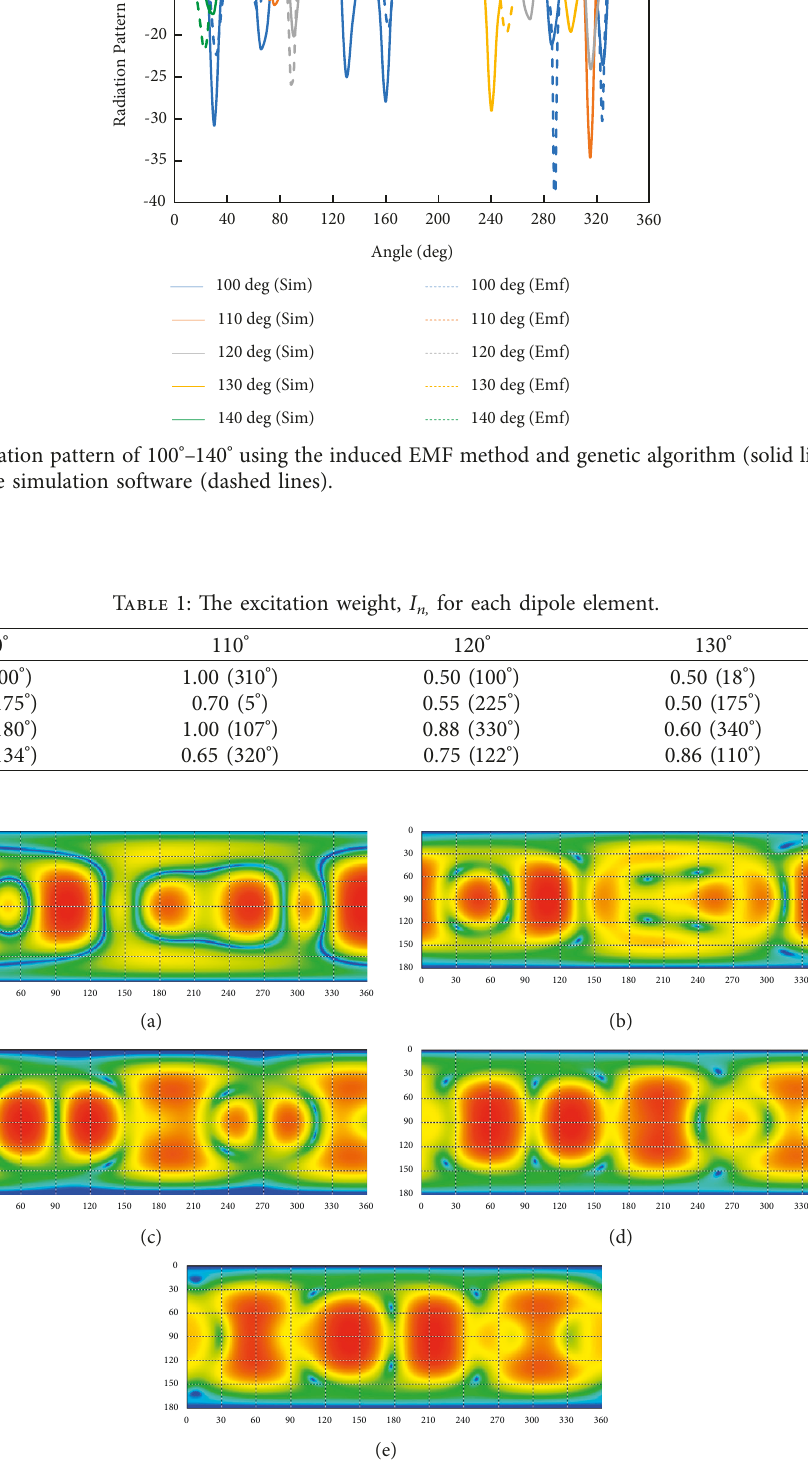
Figure 6: 2D radiation pattern of optimized beams at: (a) 100 ° , (b) 110 ° , (c) 120 ° , (d) 130 ° , and (e) 140 °